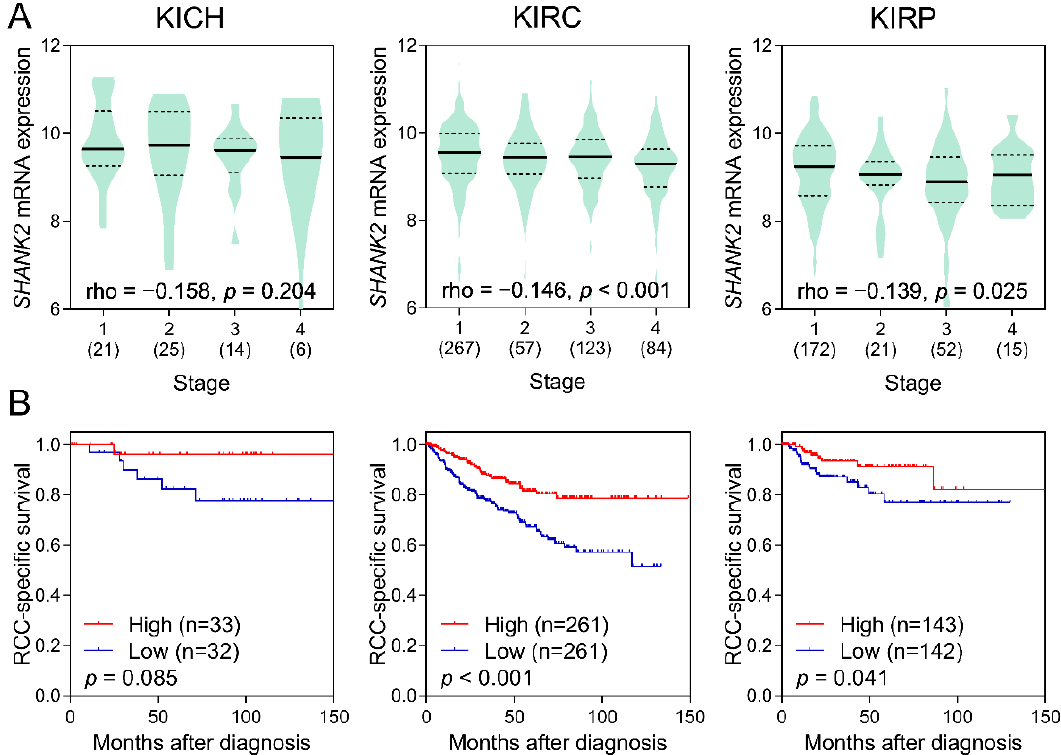
Figure 3. Correlation of SHANK2 expression levels with renal cell carcinoma (RCC) progression. ( A ) Downregulation of SHANK2 expression in advanced-stage RCCs, and ( B ) association of low SHANK2 expression levels with a poor cancer-specific survival based on The Cancer Genome Atlas kidney chromophobe (KICH), kidney renal clear cell carcinoma (KIRC), and kidney renal papillary cell carcinoma (KIRP) data. Values in brackets represent the number of patients; rho, Spearman ’ s rank correlation coefficient.